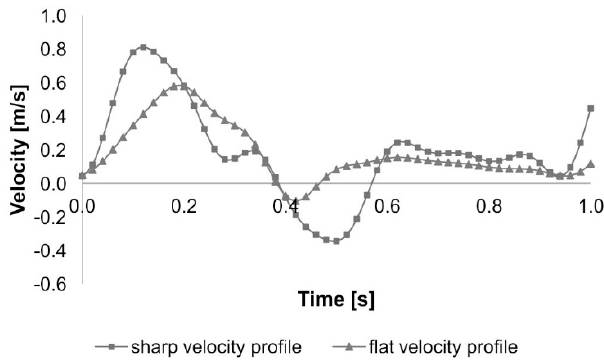
Figure 1. Sharp and flat reference of blood velocity profiles.